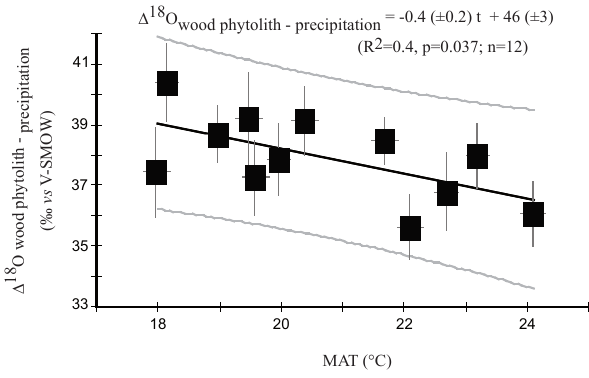
Fig. 5. Empirical relationship between 1 18 O wood phytolith - precipitation value and mean annual atmospheric temperature (MAT) obtained for the three windward transects. Grey lines: associated uncertain- ties (Tables 1 and 2) and limits of the 95% confidence interval.